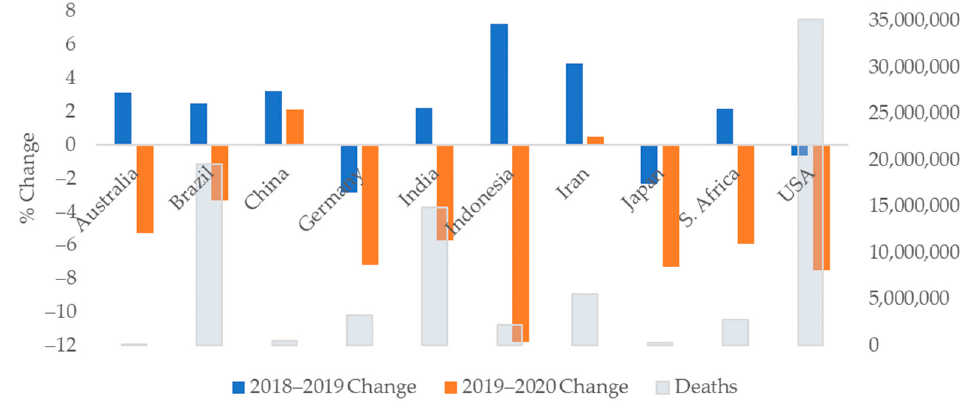
Figure 2. Change in energy consumption and 2020 COVID deaths for 10 countries [25,27].